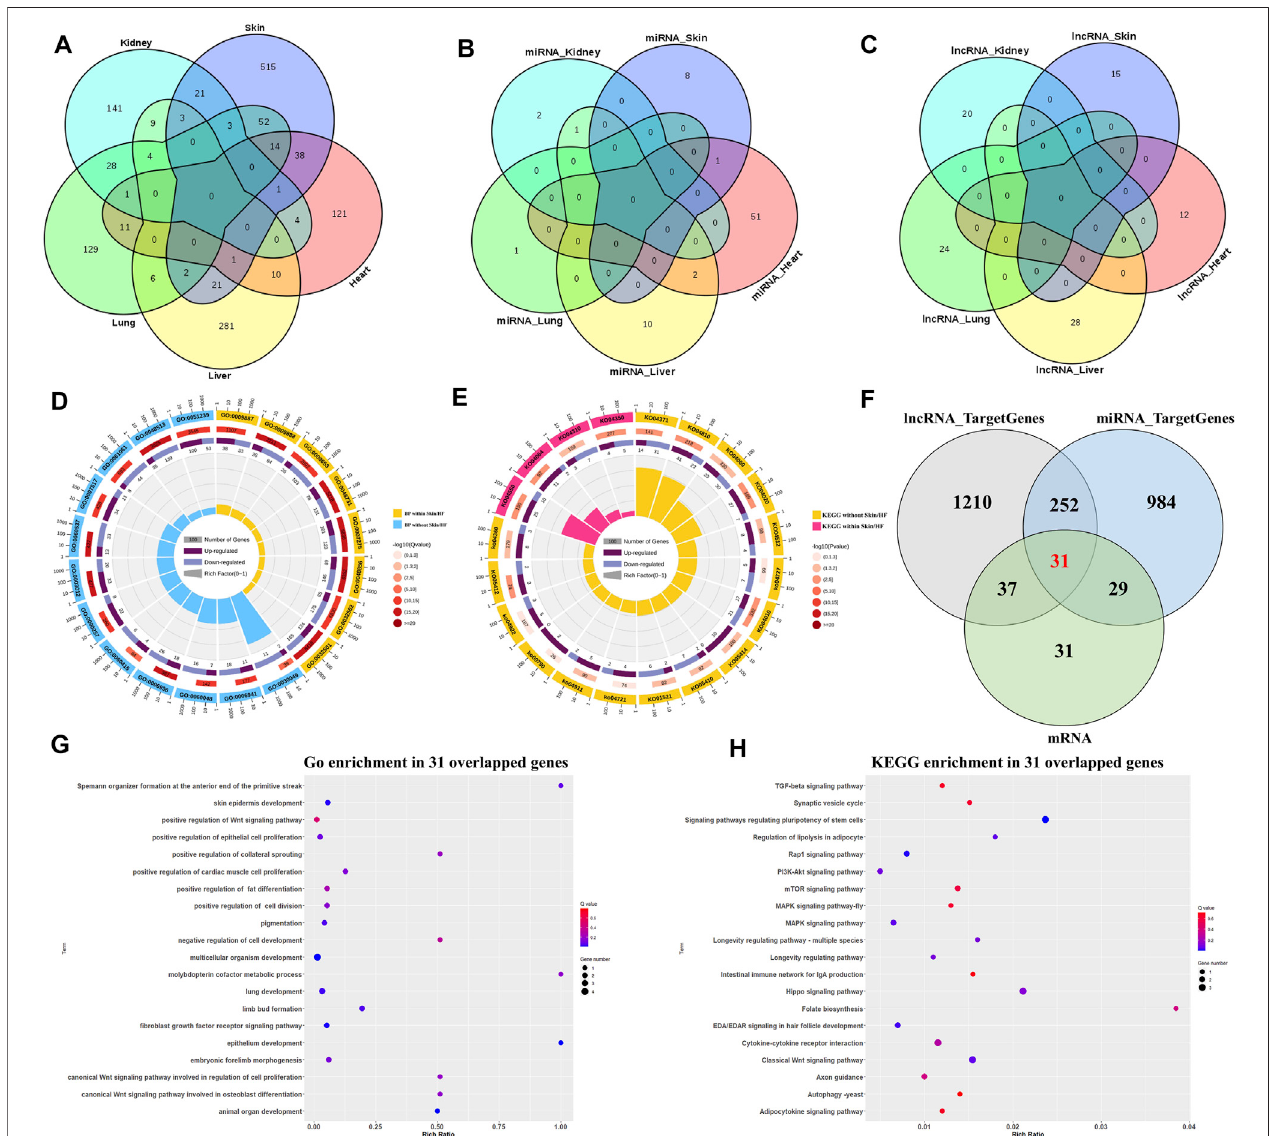
FIGURE 1| Differential expression ofmRNAs, miRNAs, and lncRNAs between hairlessand normal pig embryo skins at E41. Venn diagram for speci fi cDE mRNAs (A) , DE miRNAs (B) and DE lncRNAs (C) in skin; (D) GO enrichment analysis for DE mRNAs; (E) KEGG enrichment analysis for DE mRNAs; (F) Venn diagram of candidate target genes of DE mRNA, DE miRNA and DE lncRNA at E41 skin; (G) Top 20 terms of GO enrichment in 31 overlapped target genes; (H) Top 20 terms of KEGG enrichment in 31 overlapped target genes.